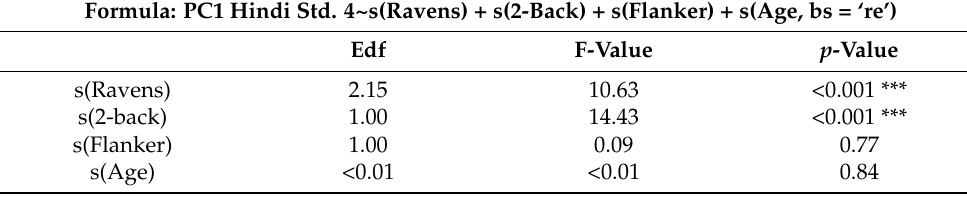
Table A1. Output of the generalized additive model for the Hindi literacy in Std. 4.